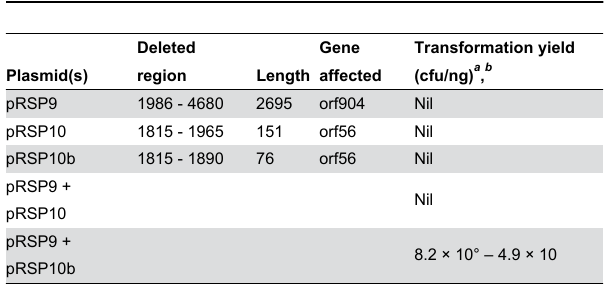
Table 4. Co-transformation of pRSP9 with pRSP10 or